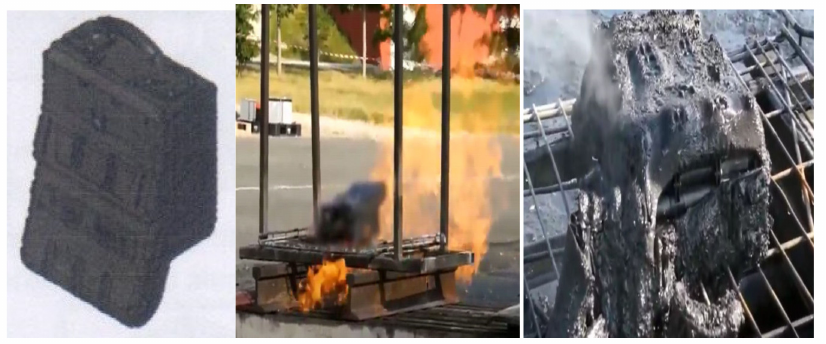
Figure 21. Exp. A.7 experiment.